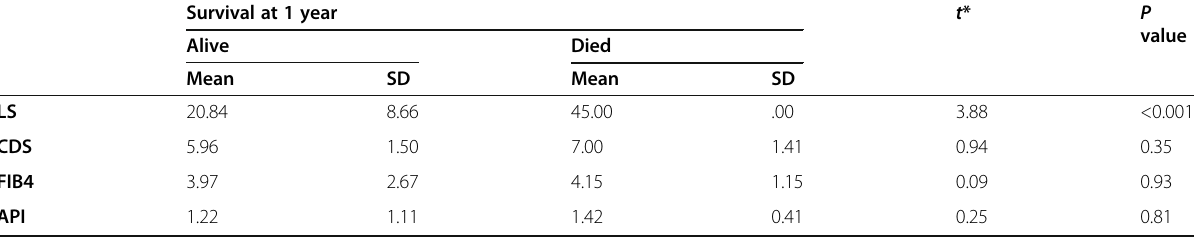
Table 5 Relation between 1-year survival and noninvasive liver fibrosis tests